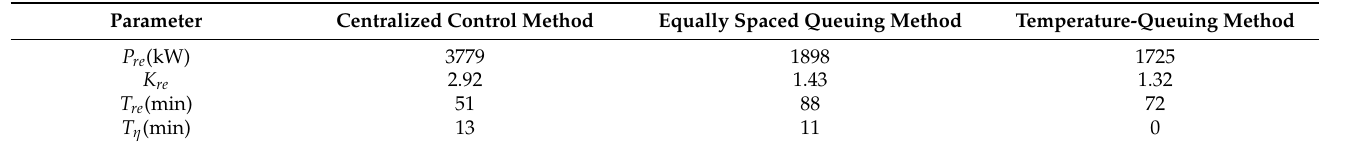
Table 4. Indicators of load curves obtained by each method.